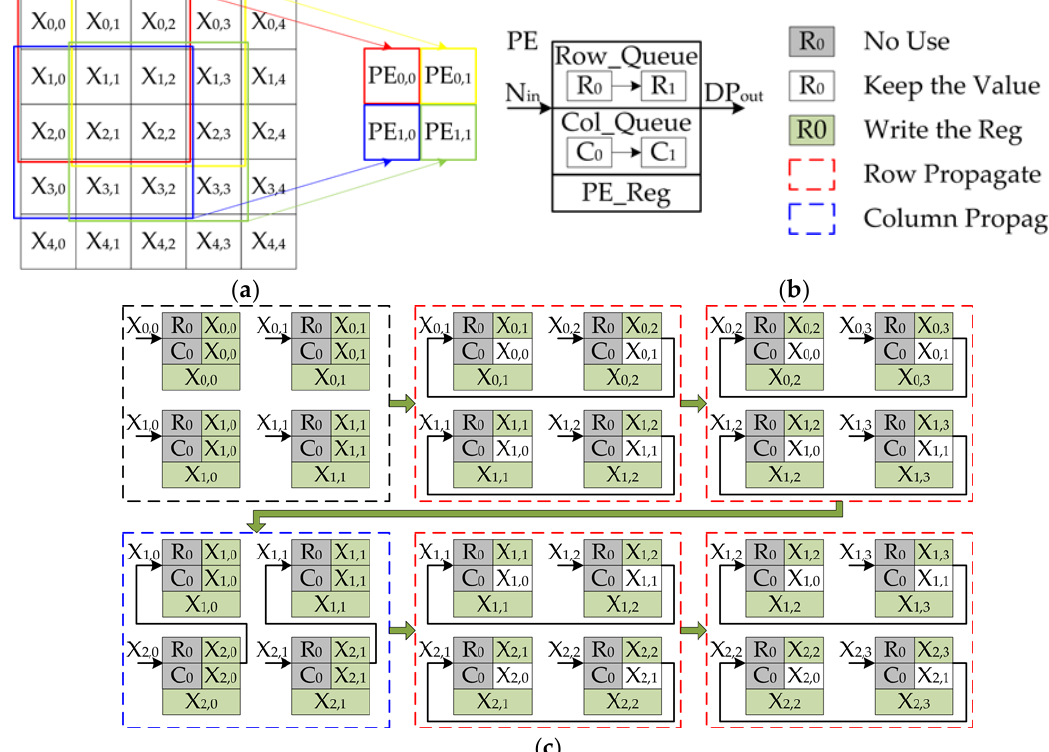
Figure 7. The neuron propagation between PEs and data reuse during the convolutional operation when stride = 1. ( a ) The mapping between neurons and PEs. ( b ) PE model, register operations, and neuron propagation between PEs. ( c ) The neuron propagation and register operation of the neuron between PEs in first six cycles during the convolutional operation.